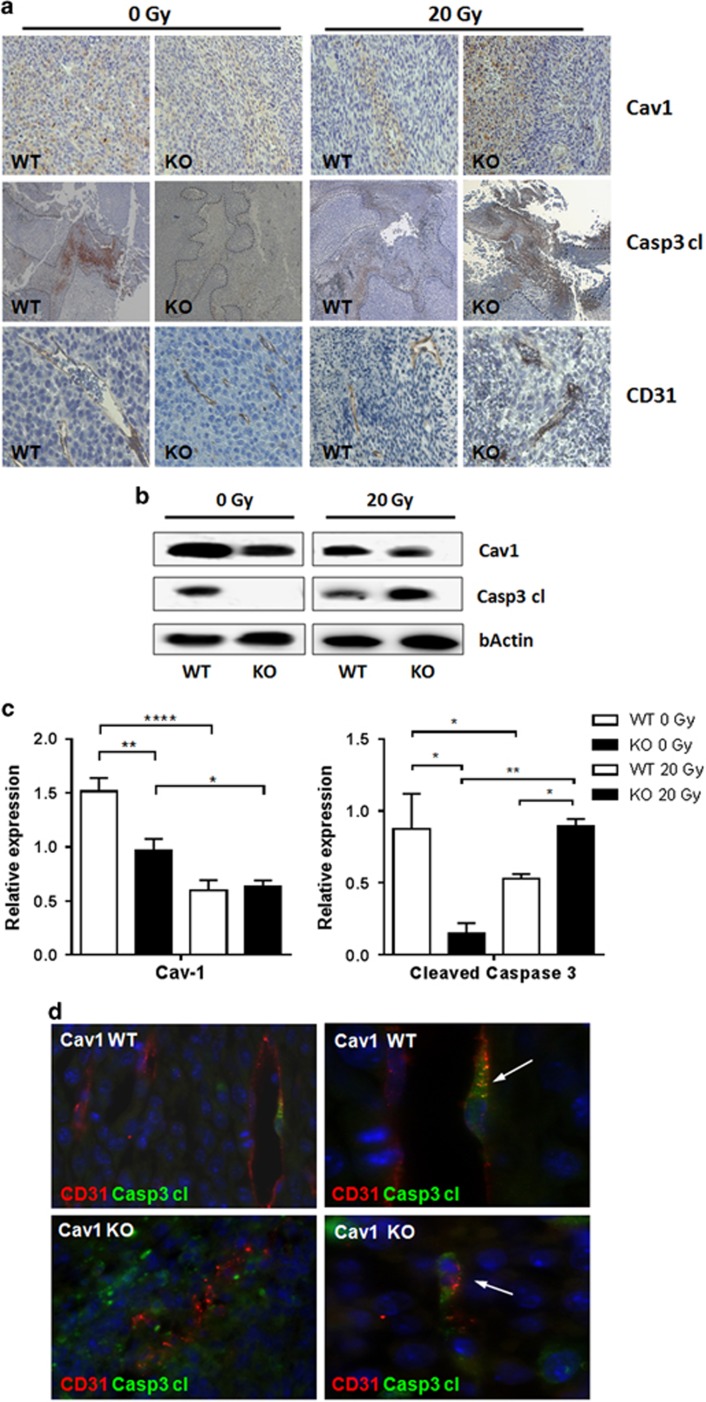
Radiation therapy induced increased caspase 3 cleavage in MPR31-4 tumors and tumor endothelial cell apoptosis in Cav1-deficient animals. (a) MPR31-4 tumor cells were subcutaneously transplanted into Cav1-deficient mice (knockout (KO)) and wild-type controls (WT). When tumor volumes reached a critical size (5–20 days after tumor irradiation) tumors were removed subjected to immunohistochemistry. Sections were stained for Cav1, cleaved caspase 3 (Casp3 cl) and CD31 proteins. Dotted lines emphasize the border necrotic and normal tumor tissue. (b) Levels of Cav1 and Casp3 cl were further determined using western blot analysis. Representative blots from at least three independent experiments are shown. (c) Protein levels were analyzed by densitometry and normalized to β-actin (bActin) levels (relative protein expression). Data show representative blots from at least three independent experiments. (d) MPR31-4 tissue sections of irradiated tumors were stained for CD31 (red) and Casp3 cl (green) or smooth muscle actin (ACTA2; pericytes/smooth muscle cell, green). Arrows point toward CD31-positive ECs, which became immunoreactive for Casp3 cl upon irradiation (4 days post XRT (post-operative radiotherapy)). Representative images from at least three independent experiments are shown. Magnification × 63.